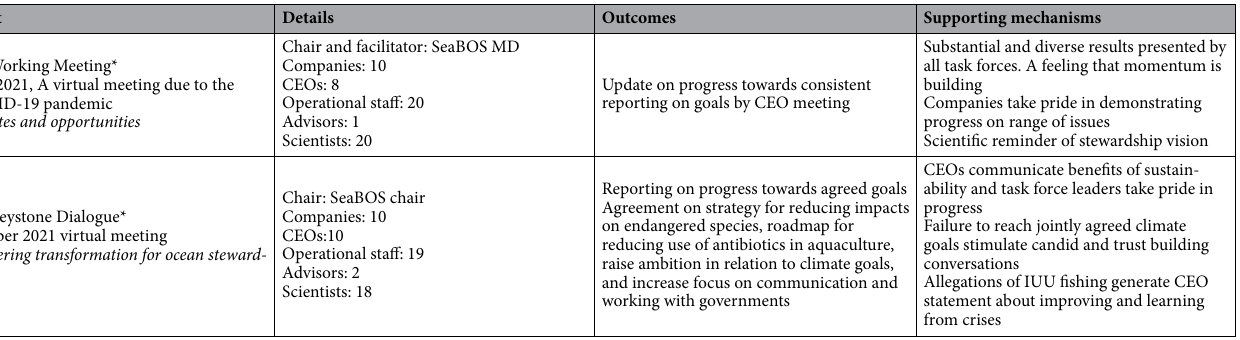
Table 2. Summary of main events, outcomes and supporting mechanisms. For detailed agendas, scientific background and results, see Supplementary Data S1. FFF forum for the future, SRC Stockholm Resilience